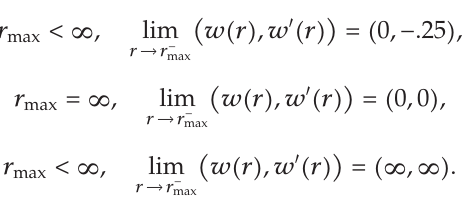
(cid:5) 0 and r (cid:5) 2 . min max